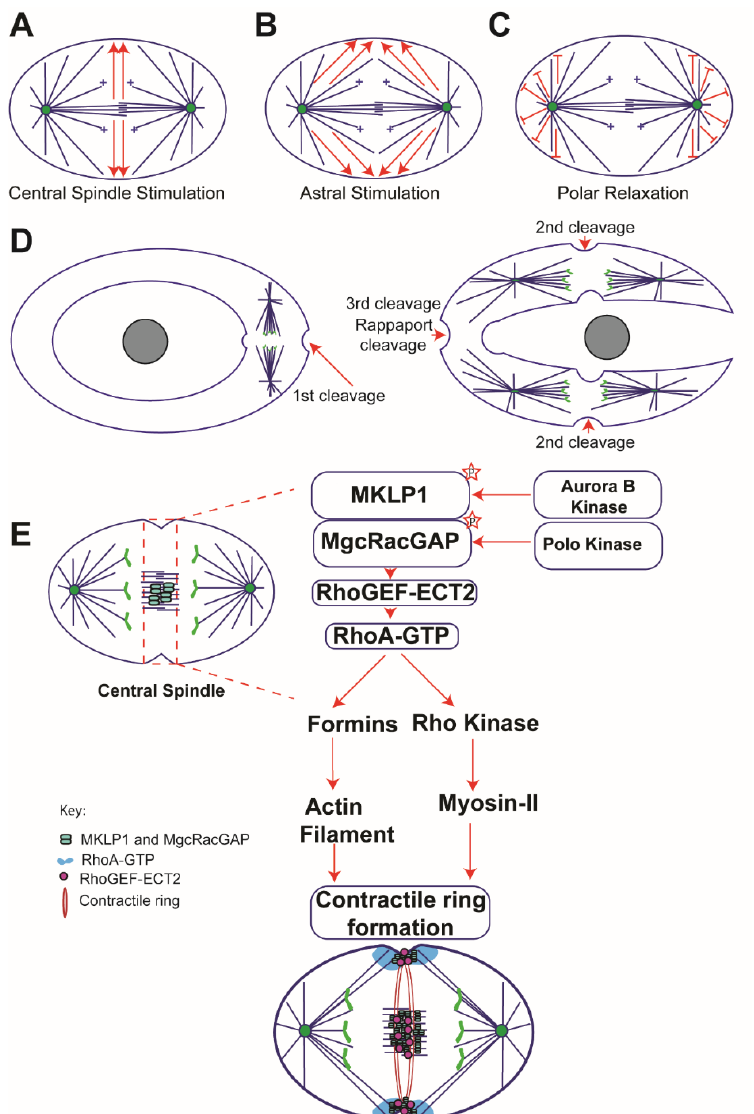
Figure 1. Classical models of cytokinesis: Schematic representation of three different models that have been proposed to position the cleavage furrow. ( A ) Central spindle stimulation model: according to this model a diffusive signal emanating from the central spindle/midzone activates RhoA, which then initiates actomyosin ring formation. ( B ) Astral stimulation model: this model posits that astral microtubules provide positive signaling cues for furrow initiation. ( C ) Polar relaxation model: this model presumes that MTs near the poles and/or segregating chromosomes carry the inhibitory signals that restrict cortical contractility in the nearby region. ( D ) Illustration of the famous Rappaport “torus experiment” in sand dollar eggs, arrow heads indicate cleavage sites and gray circle in the middle represents perforation site. ( E ) A model depicting the composition of the central spindle and assembly of the contractile ring: the centralspindlin complex, which is composed of MKLP1 and MgcRacGAP, localizes to the central spindle during anaphase. Phosphorylation of MgcRacGAP by PLK 1 generates a docking site for the RhoGEF, ECT2, at the central spindle. ECT2 activates RhoA at the equatorial cortex, which then triggers a downstream signaling cascade via Formins and Rho kinase resulting in the assembly of an actomyosin ring. Constriction of the ring results in generation of two daughter cells. Based on the assessments that equatorial astral MTs are stabilized relative to polar MTs and that MKLP1 is a plus-end directed motor, Odell and Foe developed a computational model for